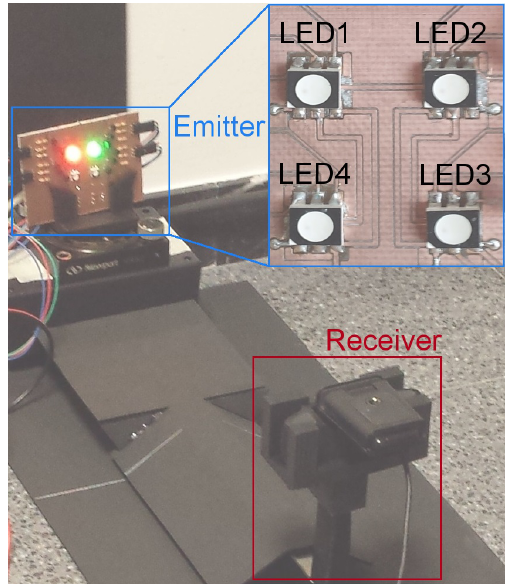
Figure 4. Implemented experimental testbed. The emitter is the designed board, controlled externally. In this case, the top LEDs were turned on in red (LED1) and green (LED2). The receiver, a USB webcam, was controlled by a PC and was located over a rail at 40 cm from the